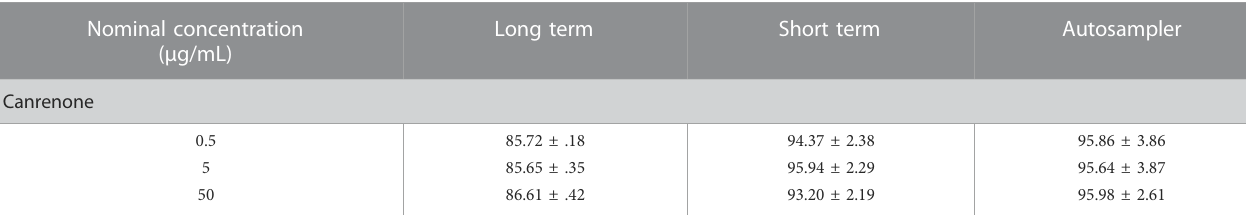
TABLE 3 Stability of canrenone in rat urine. Nominal concentration ( μ g/mL)